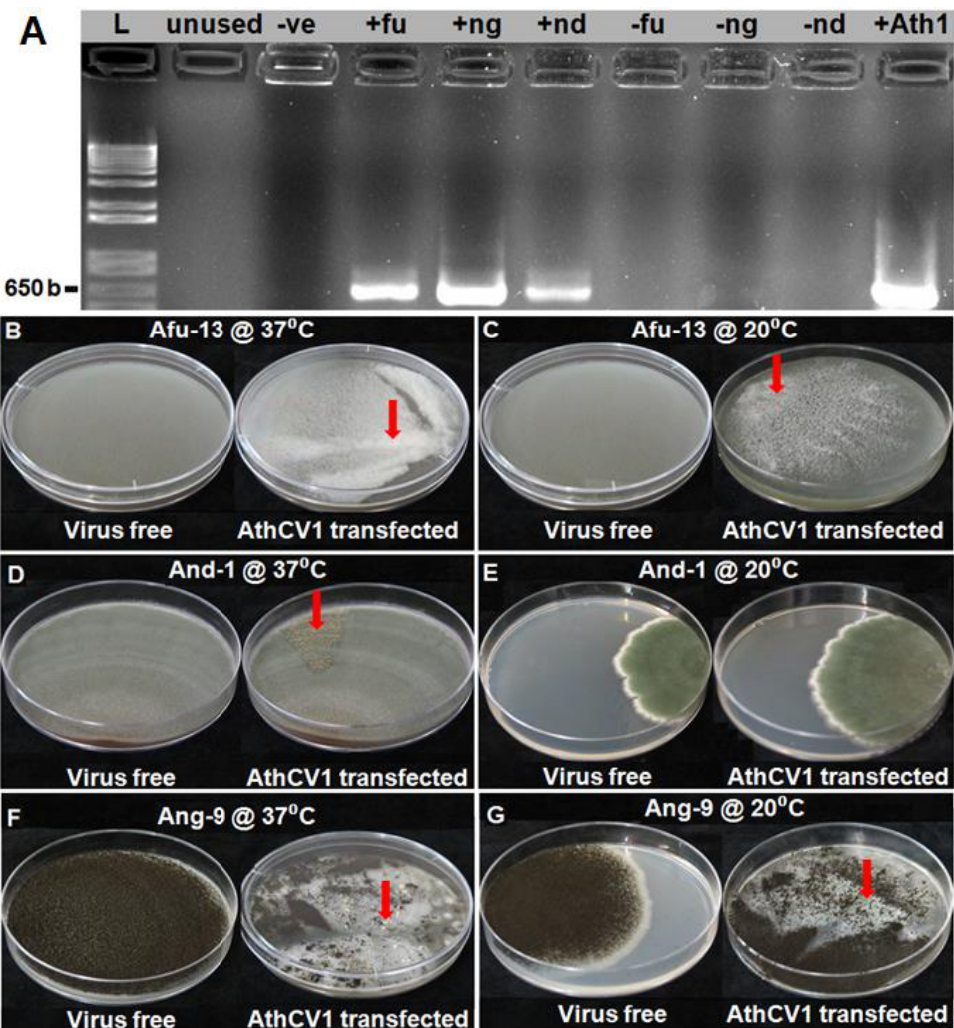
Figure 1. Effects of AthCV1 infection on the colony morphology of Aspergillus species. ( A ) polymerase chain reaction (PCR) assay showing successful AthCV1 transfection to different virus-free Aspergillus species; reverse transcription PCR, lane L = 1 kb plus DNA ladder; -Ve= PCR negative control (RNA sample was replaced with ultrapure water), +Ath1 = AthCV1 +ve control; +fu = AthCV1 transfected A. fumigatus (Afu-13); +ng = AthCV1 transfected A. niger (Ang-9); +nd = AthCV1 transfected A. nidulans (And-1); –fu, –ng and –nd = original virus-free isolates of A. fumigatus (Afu-13), A. niger (Ang-9) and A. nidulans (And-1), respectively. ( B ) Afu-13 grown at 37 ◦ C; normal growth in the virus-free isolate, sectors formed in isogenic AthCV1-transfected line (arrow). ( C ) Afu-13 grown at 20 ◦ C; normal growth in the virus-free isolate, sectors formed in isogenic AthCV1-transfected line (arrow). ( D ) And-1 grown at 37 ◦ C; normal growth in the virus-free isolate, ascospore-rich sectors formed in isogenic AthCV1-transfected line (arrow). ( E ) And-1 grown at 37 ◦ C; normal growth in both virus-free and AthCV1-transfected lines. ( F ) Ang-9 grown at 37 ◦ C; normal growth in the virus-free isolate, conidial-free sectors with sclerotia formed (arrow) in AthCV1-transfected line. ( G ) Ang-9 grown at 20 ◦ C; normal growth in the virus-free isolate, conidial- and sclerotia-free sectors in AthCV1-transfected line (arrow).